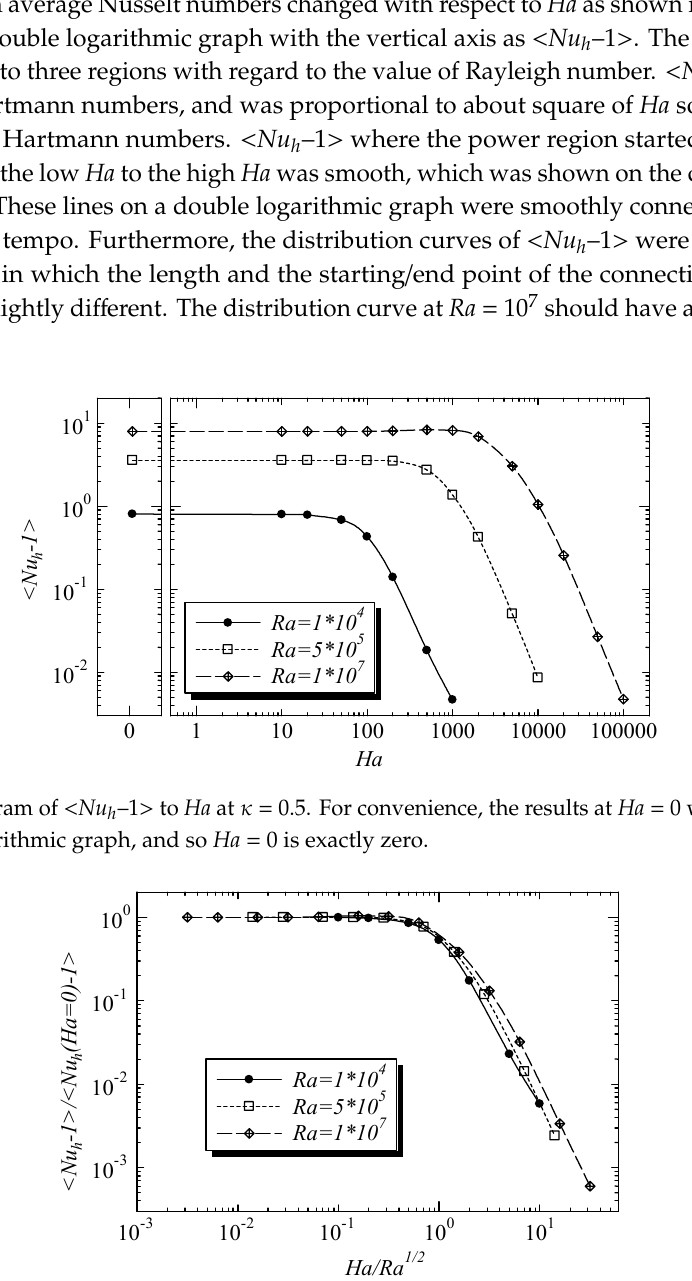
Figure 14. Diagram of < Nu h –1>/< Nu h ( Ha = 0)–1> to Ha / Ra 1/2 at κ = 0.5.